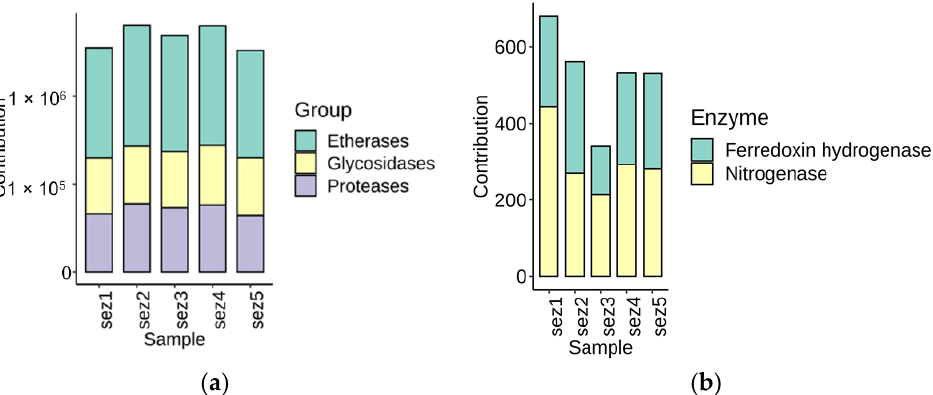
Figure 9. Contributions to hydrolytic enzyme families and hydrogen-related enzymes. ( a ) Hydrolytic enzymes are reported as a sum of esterases (EC:3.1.-), glycosidases (EC:3.2.-), and proteases (EC:3.4.-) for each sampling section; ( b ) hydrogen-related enzymes: ferredoxin hydrogenase and nitrogenase contributions; the numbers reported are the mean of the sum of contributions per taxa in each AD section, calculated by PICRUSt2.